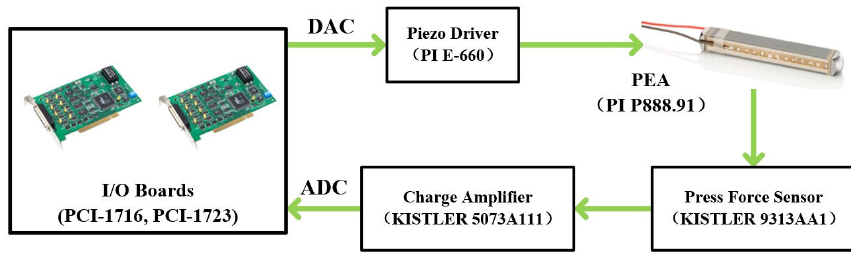
Figure 8. Schematics of system components.